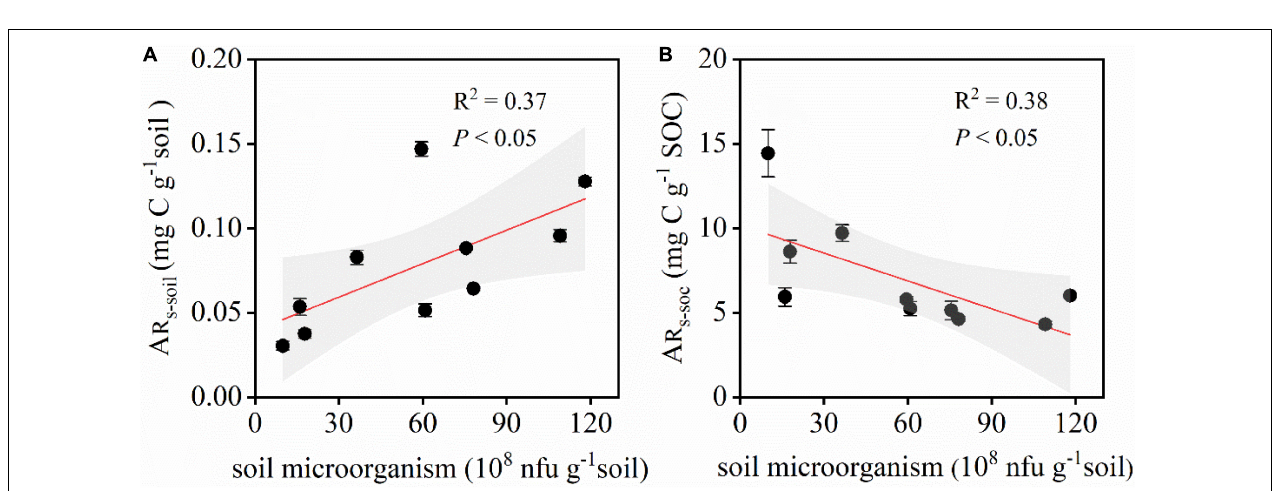
FIGURE 8 | Relationship between A Rs − soil , A Rs − SOC , and the soil microbial biomass. A Rs − soil , accumulative emission of CO 2 relative to soil mass; A Rs − SOC , accumulative emission of CO 2 relative to SOC. (A) Relationship between A Rs − soil and the soil microbial biomass. (B) Relationship between A Rs − SOC and the soil microbial biomass. Shaded areas indicate the 95% confidence interval and vertical bars denote